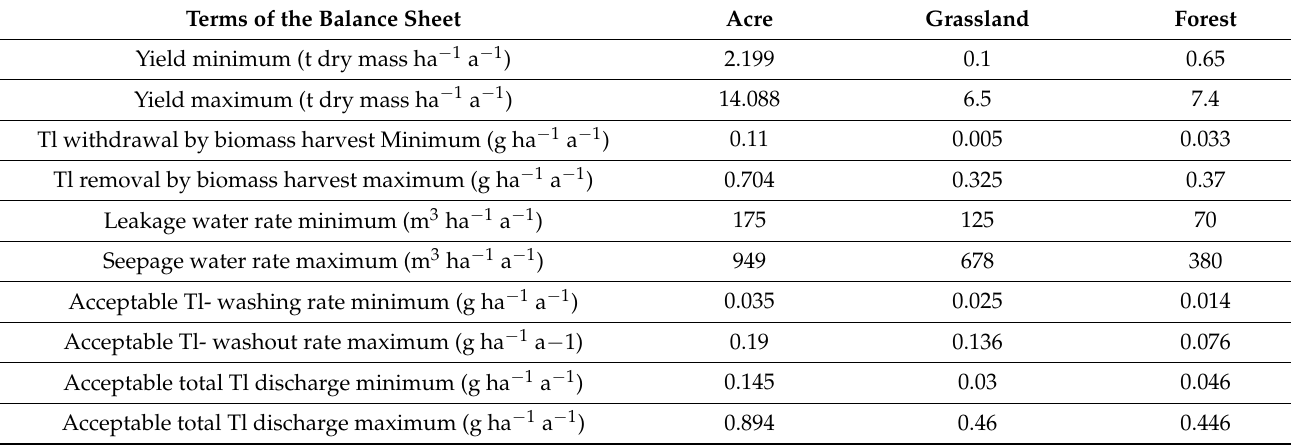
Table 14. Calculation of the acceptable Tl discharge in the typical German range (minimum and maximum). Terms of the Balance Sheet Acre Grassland